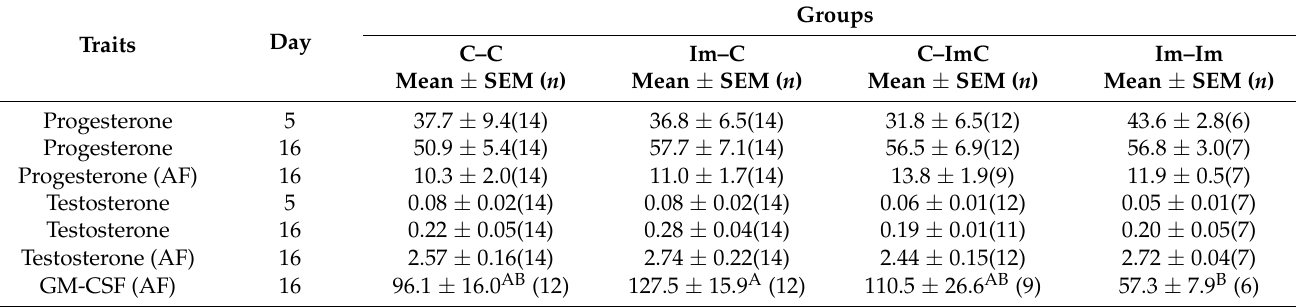
Table 4. Progesterone (ng/mL), testosterone (ng/mL), and GM-CSF (pg/mL) in blood plasma and amniotic fluid (AF) of surrogate mothers on days 5 and 16 of pregnancy.